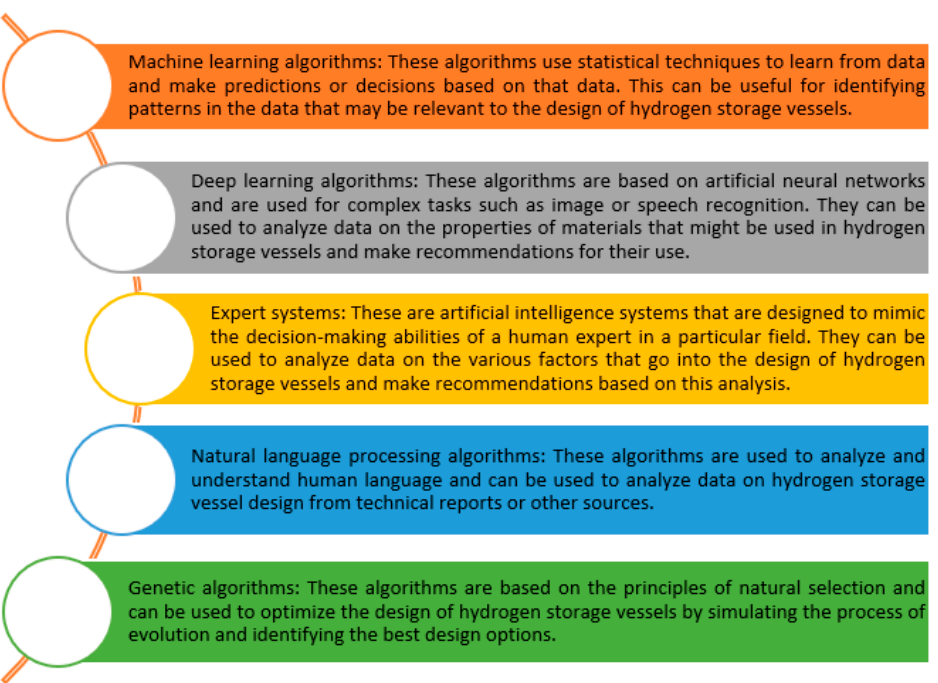
Figure 28. Machine learning fast prediction using numerical and experimental results. An objective function is required to optimize a composite pressure vessel [110]. This function must represent the performance of the composite material, and in some in- stances, local minima may exist. This objective function is utilized by optimization tech- niques to discover the optimal solution. In general, these methods can be divided into two categories: those that require simple function evaluations and those that require the com- putation of gradients. Due to the complexity of the mechanical behavior of composite ma- terials, gradient calculation may be tricky. Gradient-based approaches are, therefore,